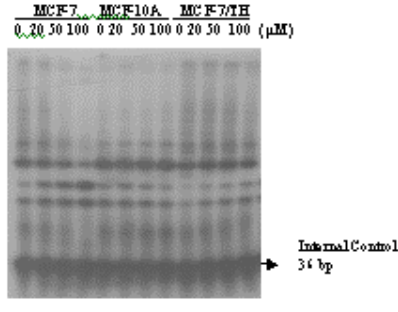
Fig. 2. Gel analysis of telomerase activity in tumor